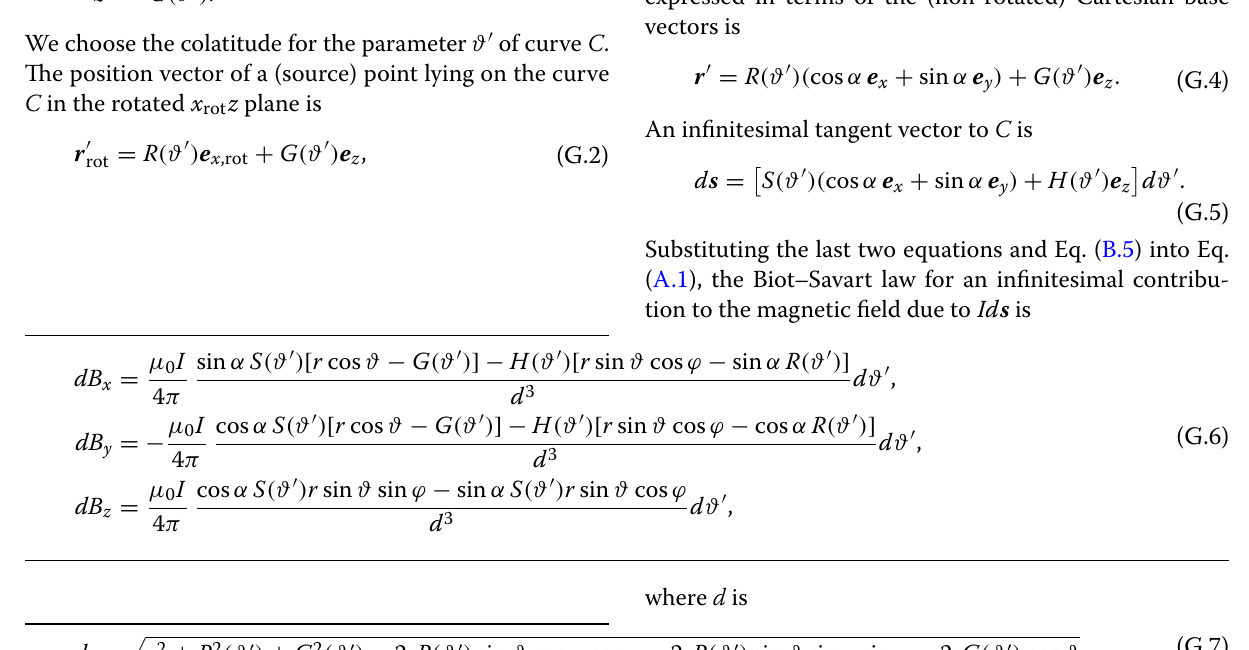
and place curve C in the rotated x rot z plane (label ‘rot’ at where the Cartesian base vector e x ,rot in the rotated x rot z x stands for ‘rotated’). The parametric equations of C in plane can be expressed in terms of the Cartesian base the rotated x rot z plane are vector in the (non-rotated) xz plane as = R (ϑ ′ ) , x ′ rot = 0, y ′ rot (G.1) Hence, the position vector of a point on curve C z ′ = G (ϑ ′ ) . expressed in terms of the (non-rotated) Cartesian base vectors is ′ We choose the colatitude for the parameter ϑ of curve C . The position vector of a (source) point lying on the curve C in the rotated x rot z plane is An infinitesimal tangent vector to C is = R (ϑ ′ ) e + G (ϑ ′ ) e , r ′ x ,rot z rot (G.2)